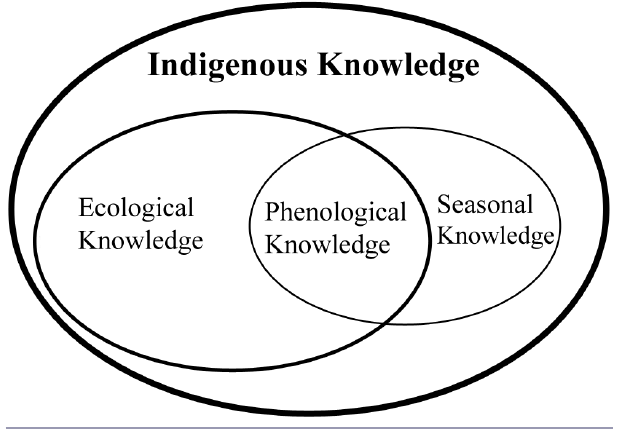
Fig. 1 . The relationship between indigenous knowledge and its